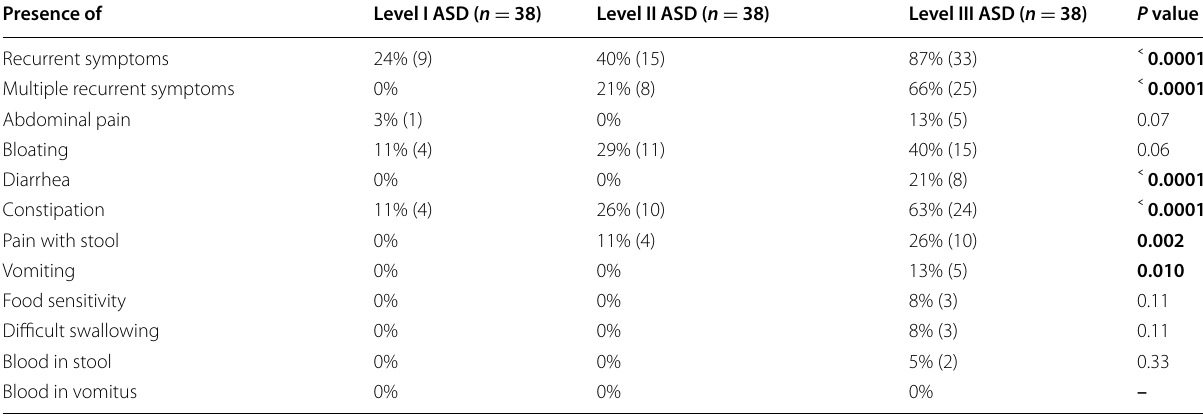
Data are expressed as a percentage (number) The P value was generated by Cramer’s V chi-square test